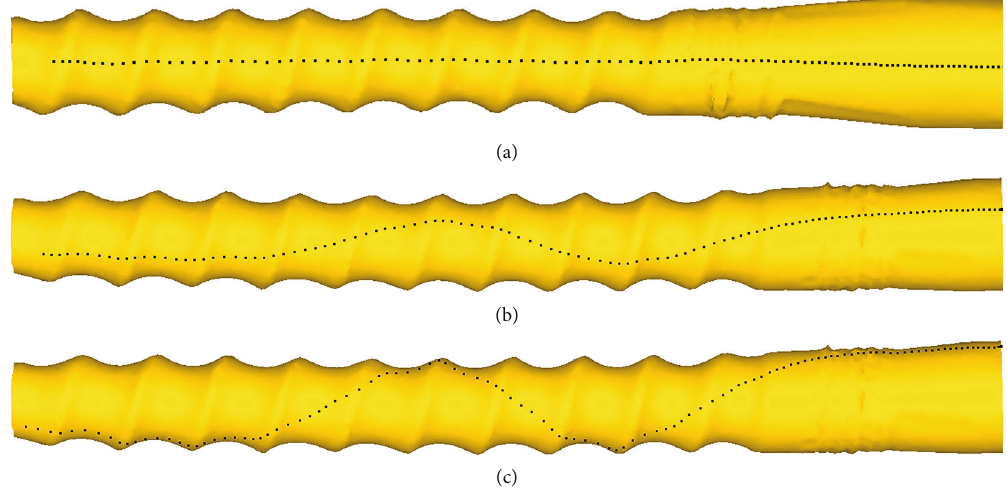
Figure 7: Metal fl ow paths in the (a) central, (b) peripheral, and (c) surface